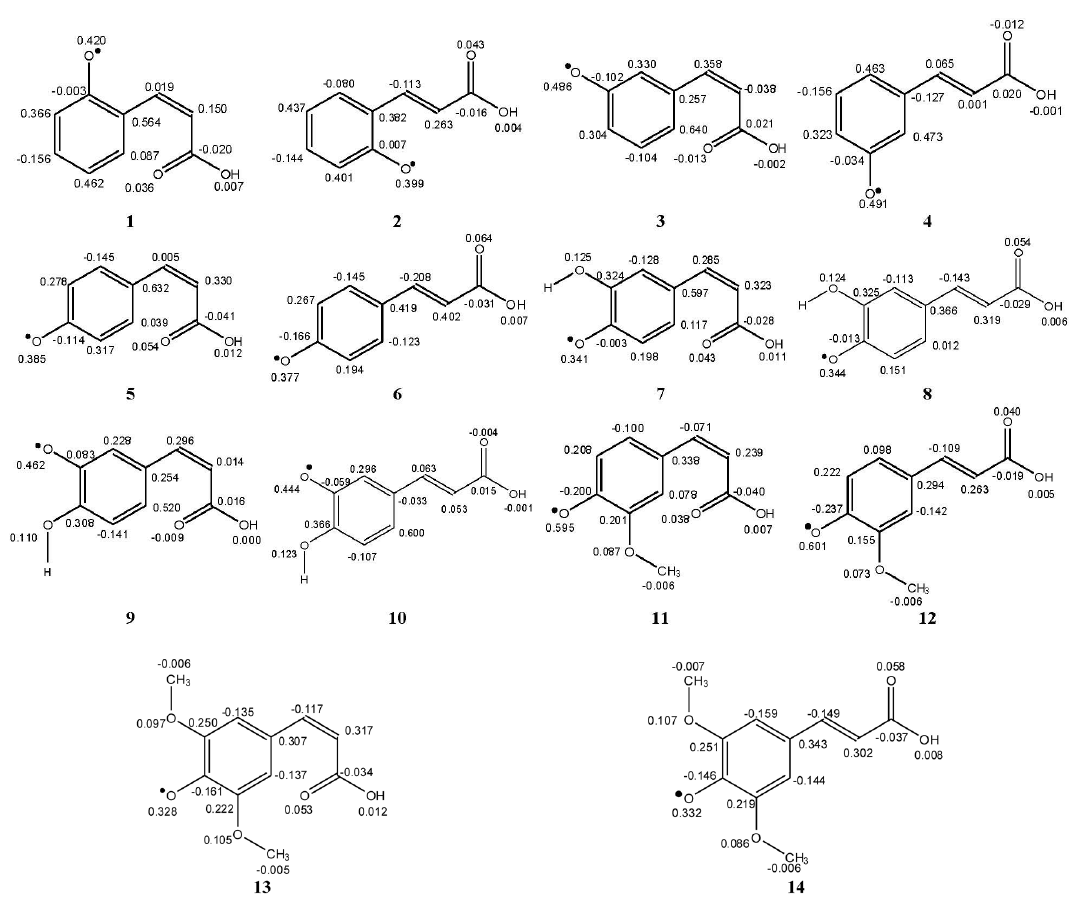
Figure 4: The uB3LYP/6-311++G(2d,2p) total atomic SD values for radicals of (1) c-o- CA 5`-O, (2) t-o- CA 1`-O, (3) c-m- CA 4`-O, (4) t-m- CA 2`-O, (5) c-p- CA 3`-O, (6) t-p- CA 3`-O, (7) c -KA 3`-O, (8) c -KA 4`-O, (9) t -KA 3`-O, (10) t -KA 4`-O, (11) c -FA 3`-O, (12) t -FA 3`-O, (13) c- SA 3`-O, (14) t- SA 3`-O in